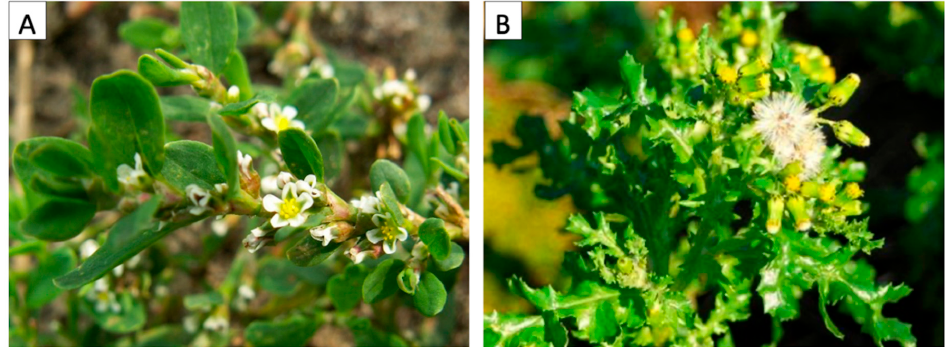
Figure 7. ( A ) Polygonum aviculare (L.), and ( B ) Senecio vulgaris (L.). Photo by Mirko Salinitro. For both plant species, five different populations were collected from five different locations: